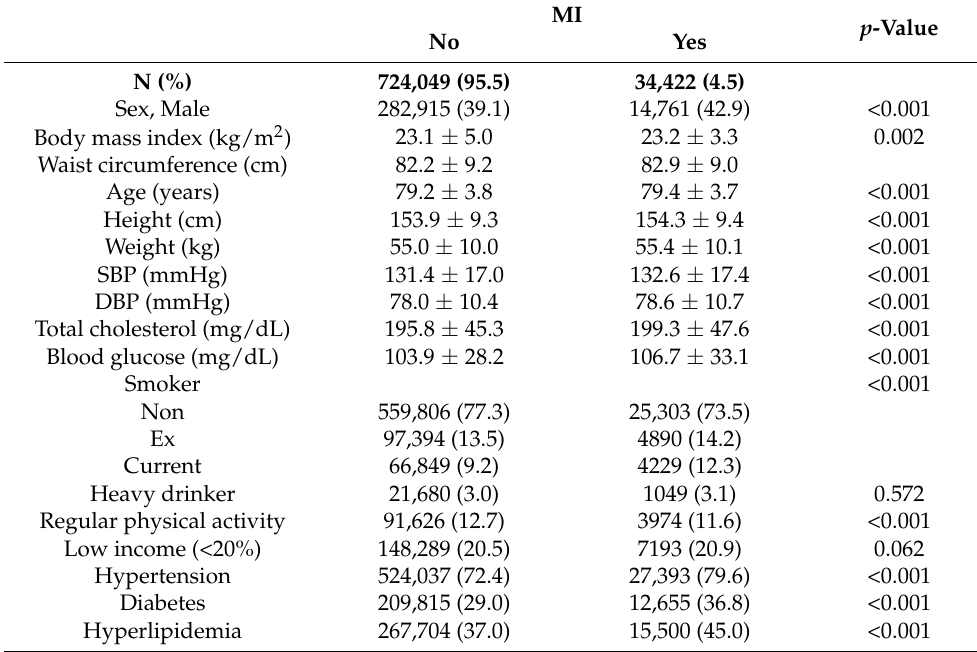
Table 2. General characteristics and risk factors in accordance with new-onset